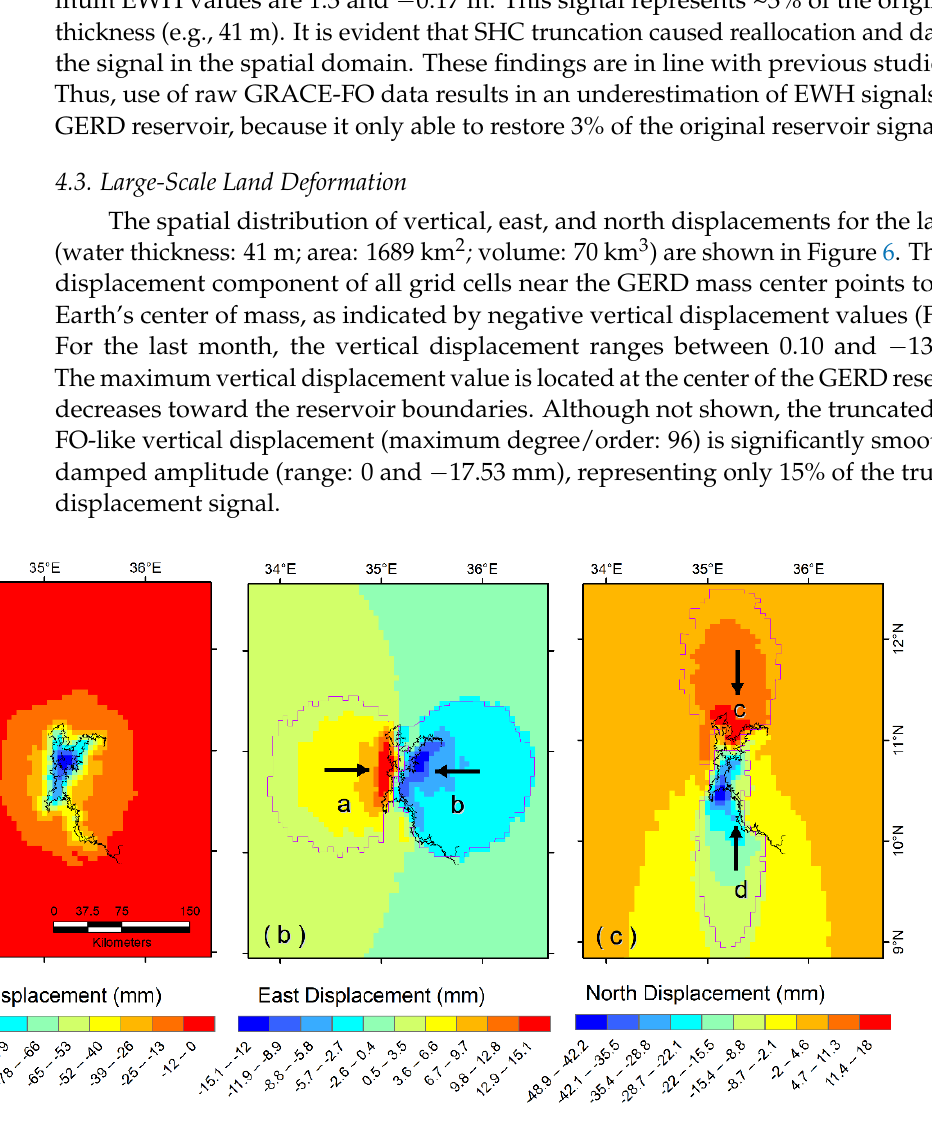
Figure 6. Deformation estimates in ( a ) vertical, ( b ) east, and ( c ) north directions, computed using the final month (water thickness: 41 m; area: 1689 km 2 ; volume: 70 km 3 ) in each filling strategy. The black arrows in Figure 6b,c indicate directions of horizontal motion. Polygons a, b, c, and d represent the projected extent of the west, east, north, and south displacements, respectively. Different color scales are used for different deformation components.